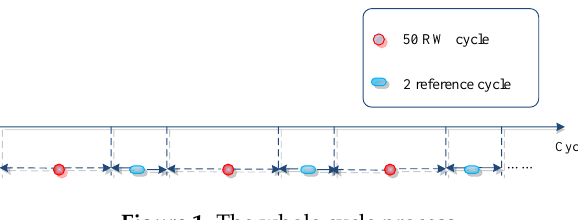
Figure 1. The whole cycle process.